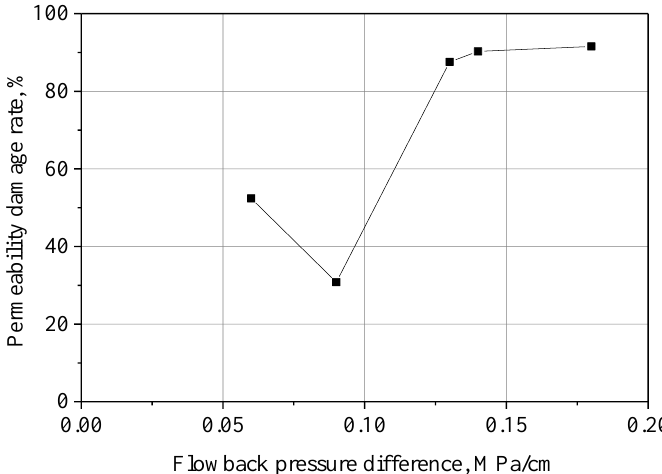
Figure 4. Relationship between outlet pressure and flowback time of five shale samples.